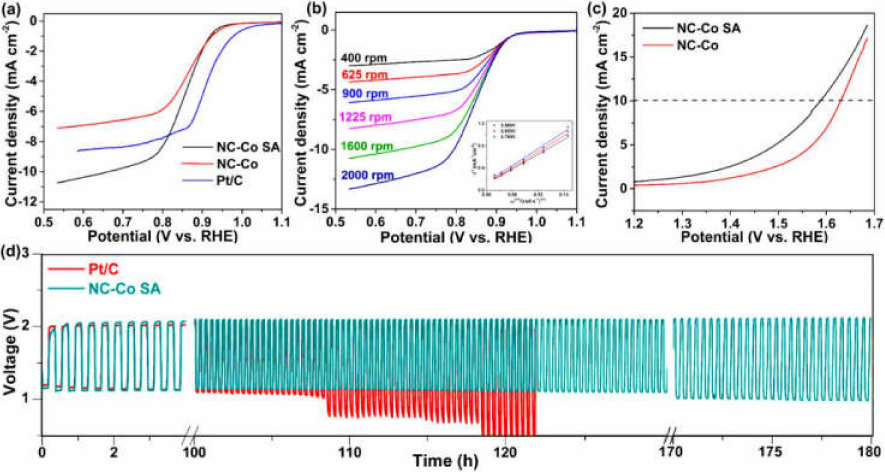
Figure 12. ( a ) Oxygen reduction polarization curves at the rotation speed of 1600 rpm. ( b ) Oxygen reduction polarization curves of NC-Co SA at different rotation speeds and Koutecky–Levich plots. ( c ) Oxygen evolution curves. ( d ) Stability test of aqueous rechargeable Zn-air batteries using NC-Co SA and Pt/C as the air cathodes. Copyright 2018 by American Chemical Society